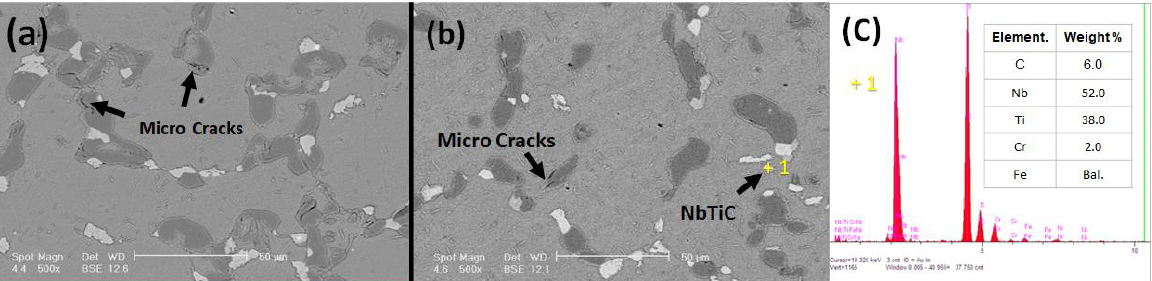
Figure 5. SEM images of tube microstructures after ageing: ( a ) Tube A without titanium and ( b ) Tube B containing 0.12 wt. % of titanium ( c ) point elemental analysis of NbTiC phase using EDS system.